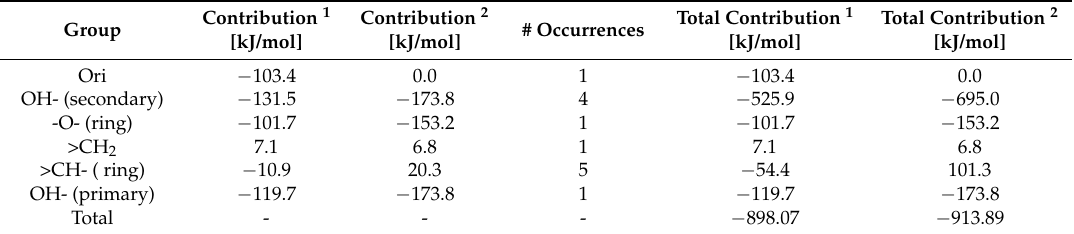
Table 3. Calculation of the ∆ f G 0 of glucose by the group contribution method. OH-groups are distinguished according to their attachment to primary or secondary carbon atoms. Contributions of groups -O- and >CH- take into account their presence in a